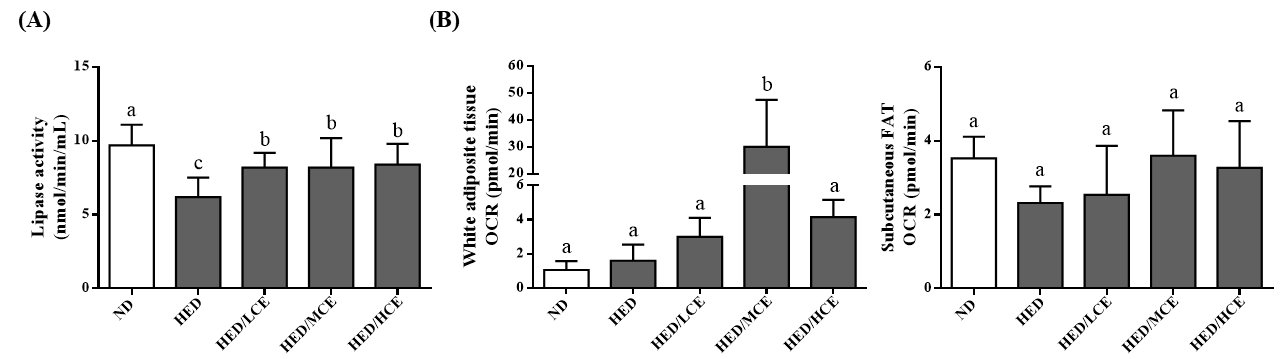
Figure 4. Effect of phlorotannin-rich extracts from A. nodosum and F. vesiculosus on ( A ) lipoprotein lipase (LPL) activity and ( B ) mitochondrial function of white adipocyte tissue and subcutaneous FAT in rats with high-energy diet–induced hyperlipidemia. ND: normal diet; HED: high-energy diet; LCE: low dosage of crude extract; MCE: medium dose of crude extract; HCE: high dosage of crude extract. Values were presented as means ± SD (n = 10). Data were statistically analyzed using one-way ANOVA followed by a Duncan post hoc test. Different letters and symbols indicate significant differences ( p < 0.05).